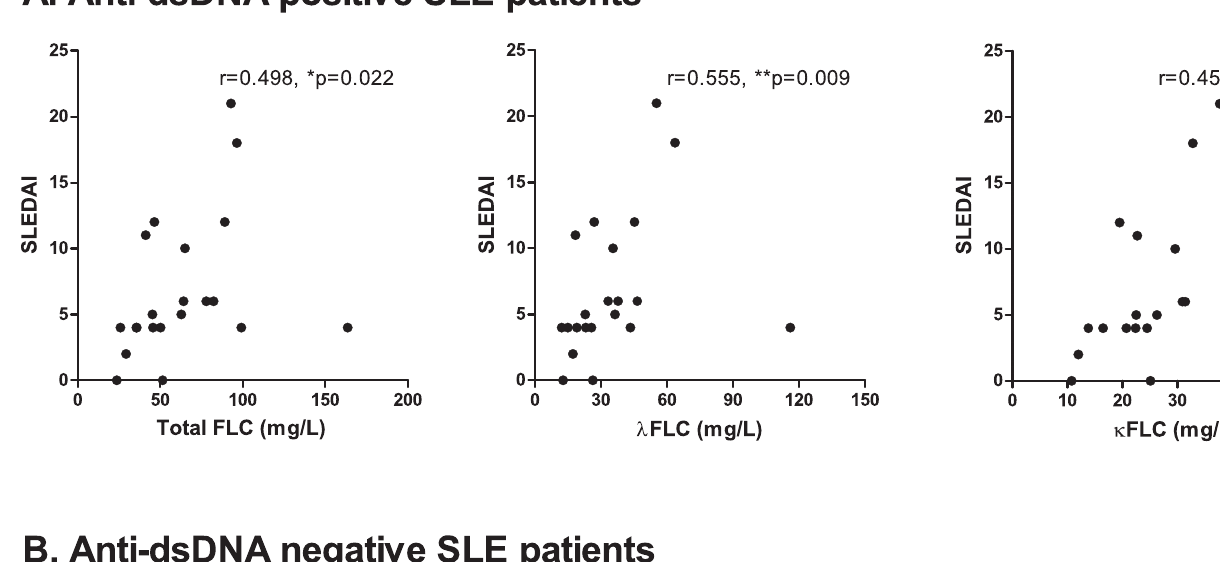
CRP SLE patients (SLEDAI range: 0 – 21, median: 4) (Fig 8A) (r-values of 0.506 (p = 0.004), 0.500 (p = 0.005) and 0.453 (p = 0.012), regarding concentrations of total FLC, λ FLC and κ FLC, respectively), but not between FLC concentrations and SLEDAI scores for low CRP SLE patients (SLEDAI range: 0 – 12, median: 4) (Fig 8B) (r-values of 0.246 (p = 0.378), 0.393 (p = 0.148) and -0.056 (p = 0.844), regarding concentrations of total FLC, λ FLC and κ FLC, respectively). No correlations were found between FLC concentrations and neither lymphocyte, leuko- cyte, nor thrombocyte levels (results not shown).